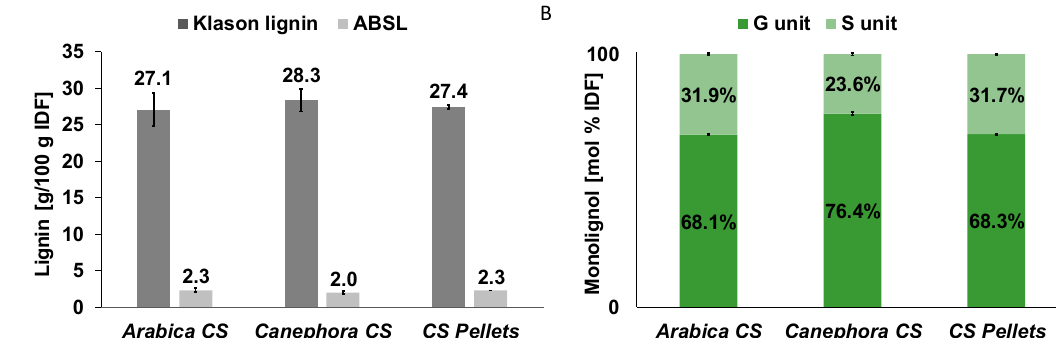
Figure 3. Insoluble dietary fiber (IDF) lignin contents according to Klason and acetyl bromide soluble lignin (ABSL) methods ( A ), and monolignol ratios liberated from IDF following thioacidolysis ( B ) of coffee silver skin from Coffea arabica ( arabica CS) and Coffea canephora ( canephora CS) and coffee silver skin pellets (CS pellets). S-unit, syringyl units; G-unit, guaiacyl units; n = 2.